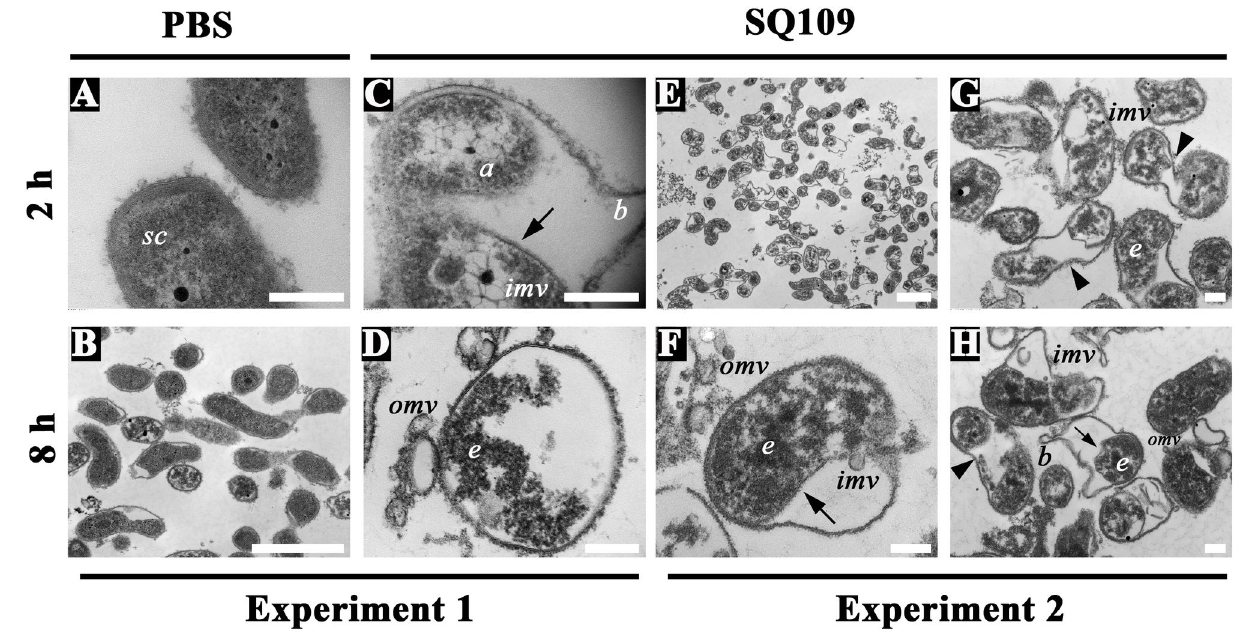
Figure 7. TEM analysis of SQ109-induced morphological and ultra-structural changes in H. pylori -cell wall, membranes, and cytoplasm. Approximately 6 x 10 7 H. pylori cells were sampled following 2 h (top panels) or 8 h- (bottom panels) of culture in the presence of PBS ( A and B ) as a negative control or 140 µM SQ109 (C, D, E , F , G , and H ). Bacterial cells cultured in the presence of 100 µM AMX or 20 µM C K-2β were included as positive controls (data shown in Figure S3). PBS-treated negative 12 12 control cells showed evidence of normal spiral-comma rod shaped morphology in addition to smooth homogenous cytoplasm ( sc ) and intact cell walls ( A , B ). In contrast, after 2 h of culture, SQ109 induced the formation of spindle actin-like cytoskeleton structures ( a ) in some cells ( C ) that appeared to condense cytoplasmic contents and lead to detachment of the IM from OM (arrows; C , E , F , G , and H ) of nearly all cells resulting in complete disappearance of the periplasmic region; 95-99% of these cells also showed a deformed coccoid morphology ( E , G , and H ). After 2h and 8 h treatment with SQ109, the cells further showed blebs ( b ), electron- dense structures ( e ), evidence of complete loss of the IM and part of the cell wall with only the OM remaining intact ( D ), formation of two aberrant cytoplasmic bodies from a single cell (arrowheads) ( G and H ), and formation of outer membrane vesicles (omv) and inner membrane vesicles (imv) ( C , F , G , and H ). All scale bars are of 200 nm except B and E which measure 1500 nm. Representative images from two independent experiments are presented. doi: As shown, PBS-treated cells showed an intact cell wall with spindle cytoskeleton structures (a) that appeared to condense both inner (IM) and outer (OM) membranes appearing largely the cytoplasmic contents to form inner membrane vesicles unperturbed. In addition, these cells tended to display a (imv) (Figure 7C, Figure S3-J). Figure 7D shows complete dissolution and separation of the inner membrane from the uniformly smooth bacterial cytoplasm, sc (Figure 7A and 7B, outer membrane with evidence of formation of outer membrane Figure S3-A, B, and C). In contrast, bacterial samples exposed vesicles (omv) and subsequent lack of periplasm. In addition, to AMX showed separation of inner membranes from the outer SQ109 appeared to interact with cytoplamic target(s) as membranes (arrows), blebs ( b ), outer membrane vesicles indicated by the presence of electron-dense structures (e) in (omv) and ghost cells (gc) indicative of cell lysis (Figure S3-D, the cytoplasm of nearly all the cells examined after 2 h or 8 h E and F). Like PBS-treated cells, AMX-treated bacteria typically exposure to the peptide (Figure 7C–H, Figure S3-J–L), showed uniformly smooth cytoplasm (sc). The treatment of the suggesting that SQ109 may also interact with bacterial bacteria with C K-2β revealed the formation of pores (p) and 12 12 cytoplasmic macromolecules, possibly nucleic acids and/or sloughing (s) in the outer membrane and electron-dense proteins [33]. There was also evidence of SQ109-induced structures (e) in the cytoplasm (Figure S3-G, H and I). The disintegration of the inner membrane (Figure S3-K arrowheads) results observed with AMX- or C K-2β -treated cells are 12 12 as well as an aberrant formation of two cytoplasmic bodies similar to our previous data [33]. from a single cell (arrowheads) (Figure 7G and H, Figure S3-L) and the formation of inner membrane vesicles (imv) (Figure 7C, F, G , and H ; Figure S3-J and K).